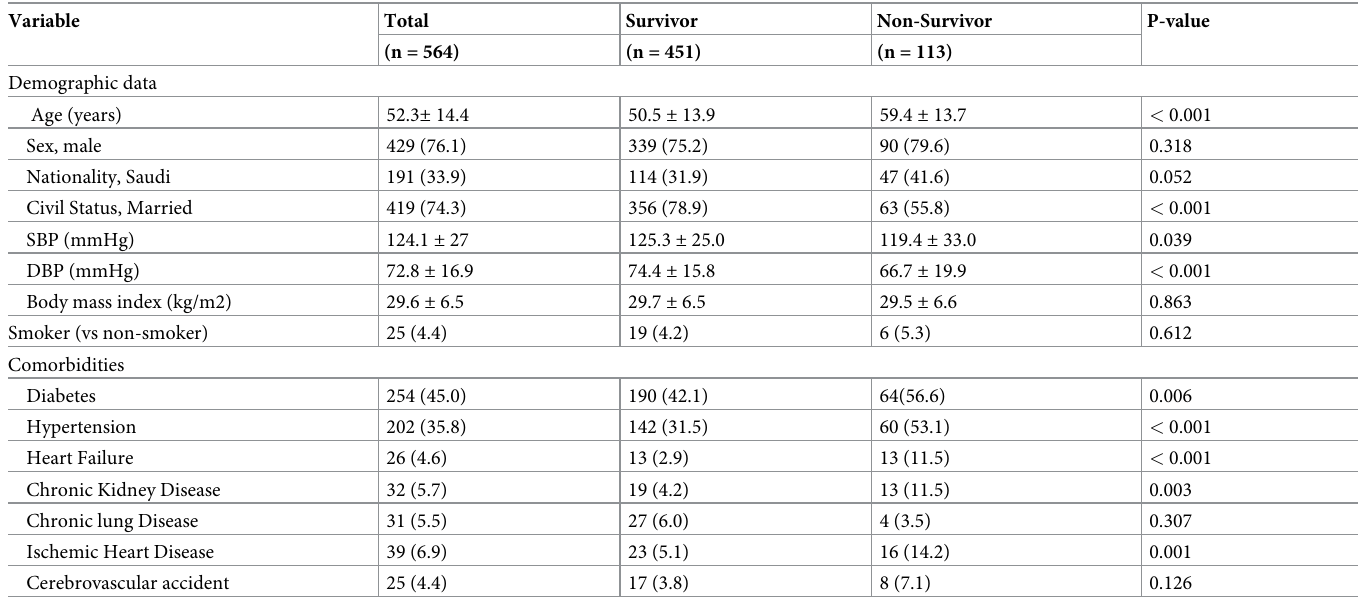
Table 1. Baseline characteristics of patients with